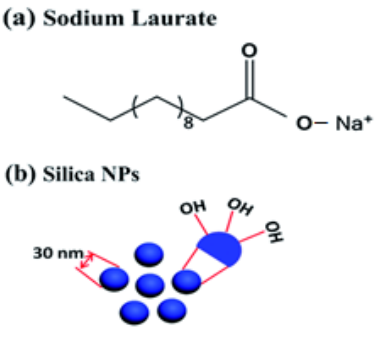
Figure 6. Hydrogel formed by the co-assembly of sodium laurate and silica nanoparticles.